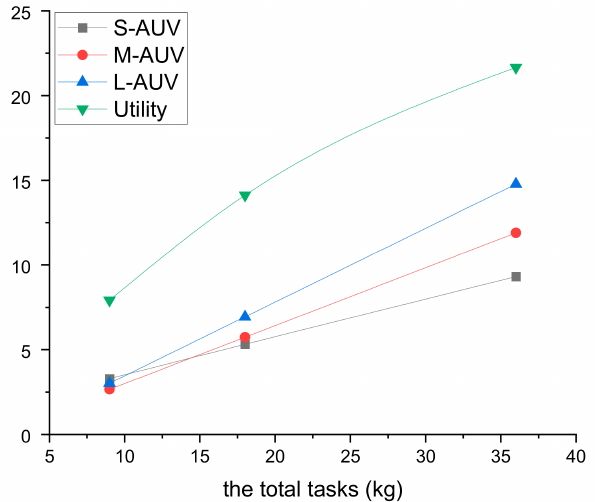
Figure 4. The line chart of the values simulated in the middle-scale system under three different w total .